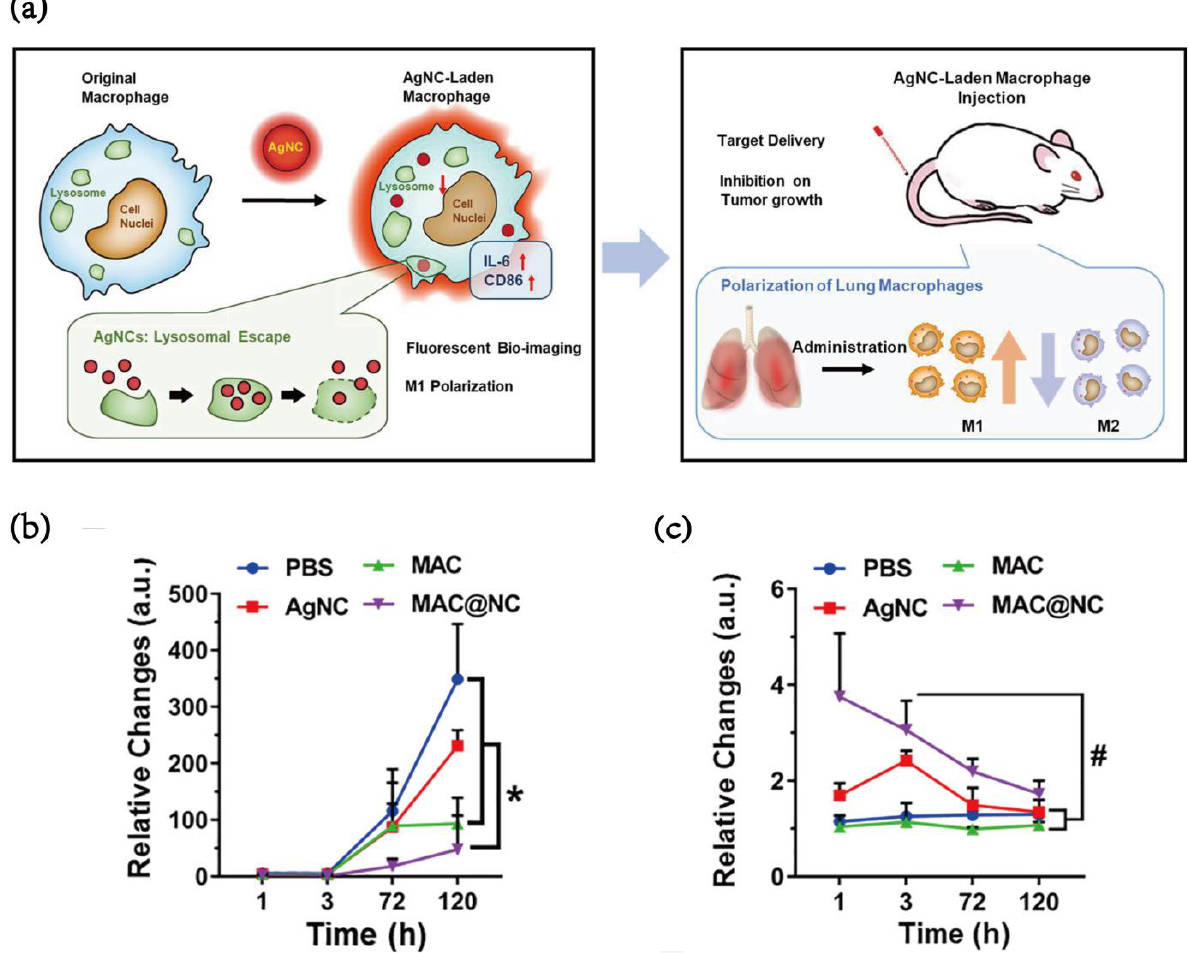
Figure 5. ( a ) Schematic diagram of silver nanoparticles-regulating macrophages. ( b ) Quantification of metastatic tumor growth in the lungs over time, ( c ) Relative changes of AgNC signals relative to the untreated control, where i.v. injection of 4T1-LG12 cells was performed (1.0 × 105 cells/mouse, n = 5), followed by treatments with PBS, AgNC, MAC and MAC@NC for 18 d Statistical analysis between groups: (*) p < 0.05 and (#) p < 0.001. [35]. Copyright 2022, Elsevier.